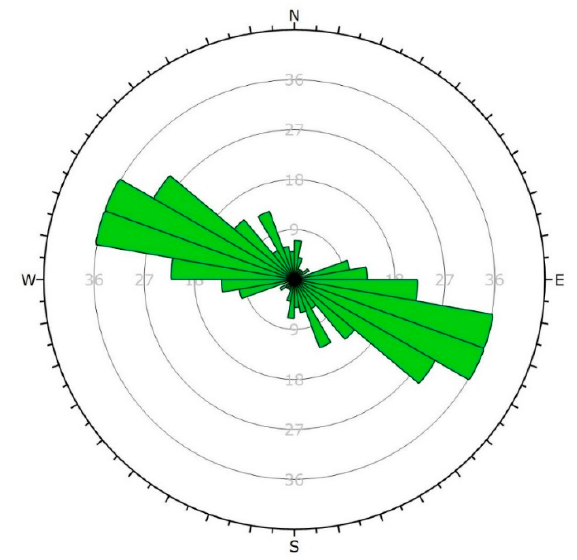
Figure 13. Rosette plot of bedding planes.